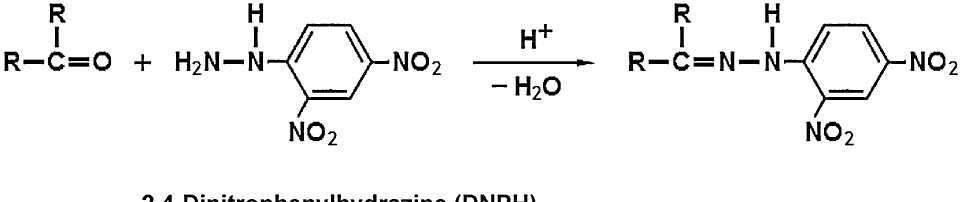
Figure 1. The reaction between carbonyls and 2,4-dinitrophenylhydrazin (DNPH) forming the corresponding